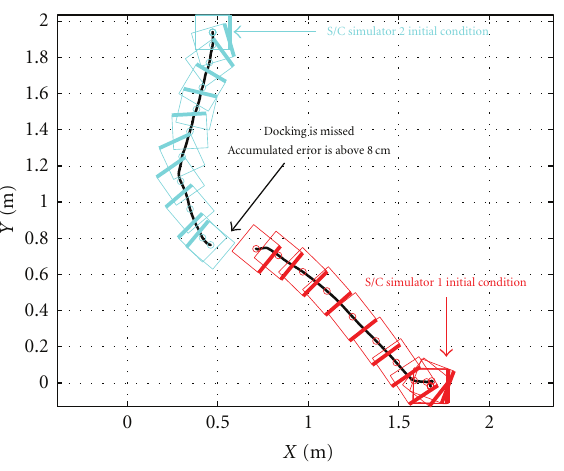
Figure 13: Experimental Result: bird’s eye view for two spacecraft simulator failed assembly maneuver. The relative navigation is performed via classical Kalman Filtering, no Augmented State Estimation. The bolded lines are employed to help visualize the simulator’s